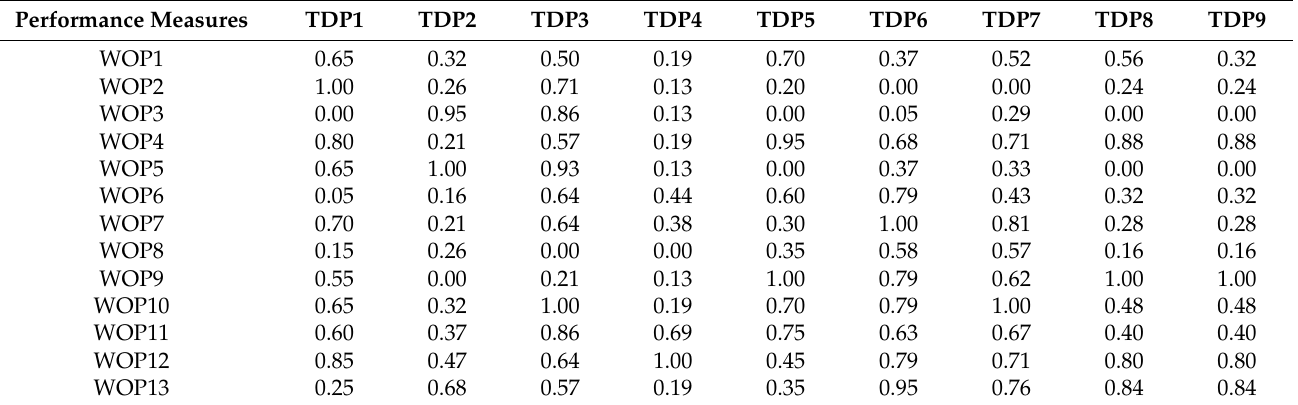
Table 10. Normalized decision matrix.